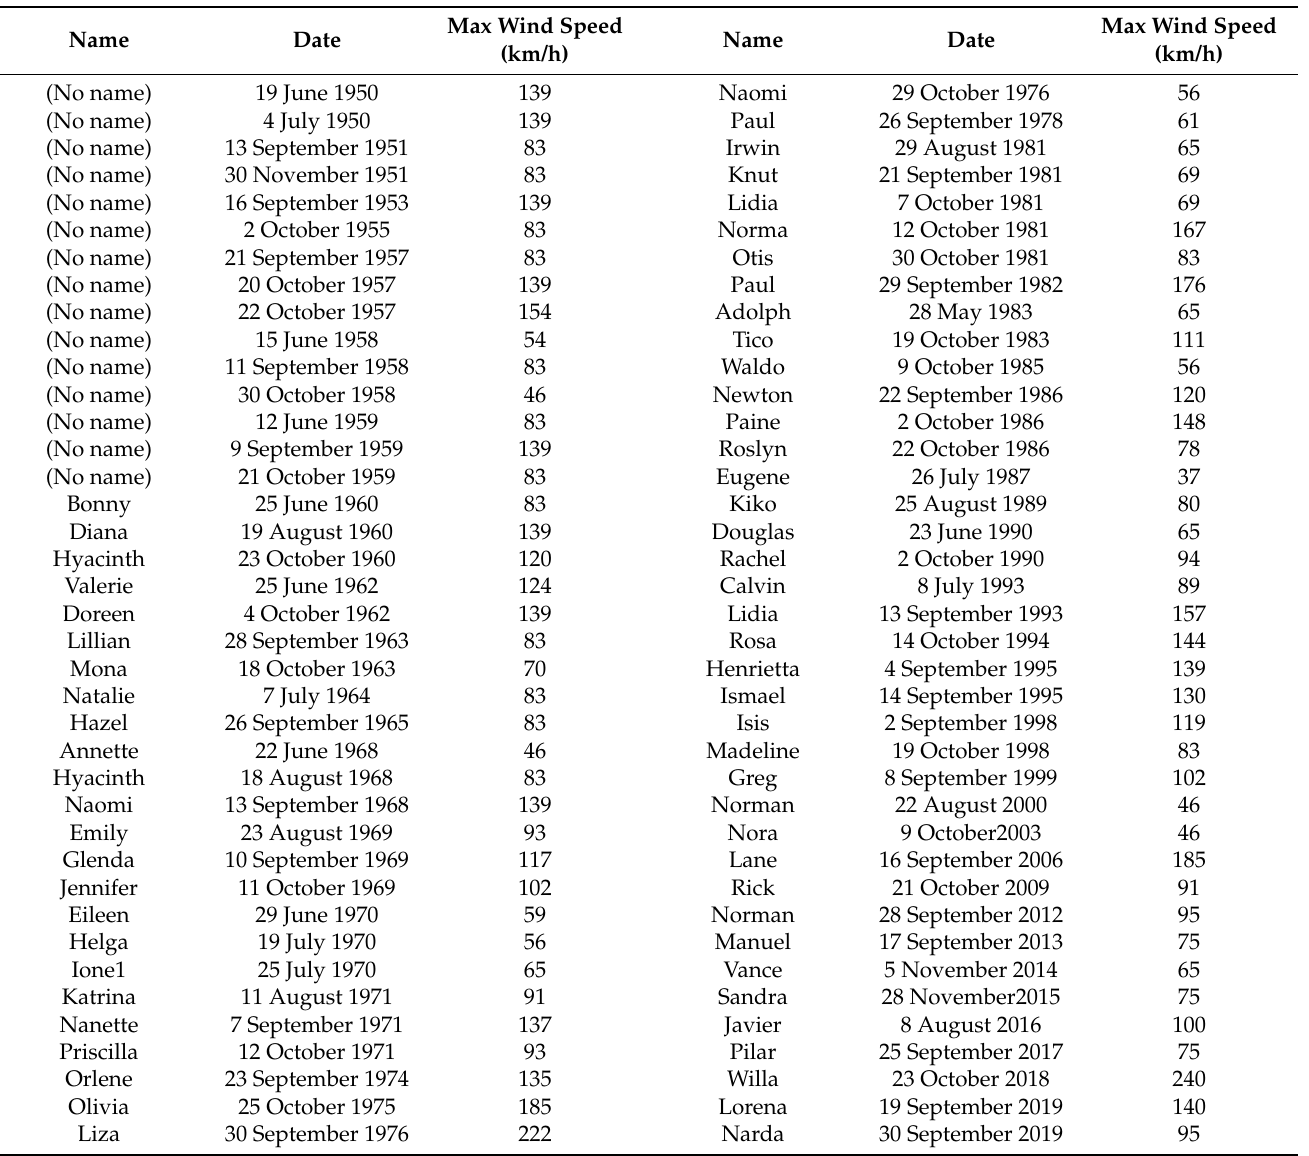
Table A1. Extreme weather events from 1950 to